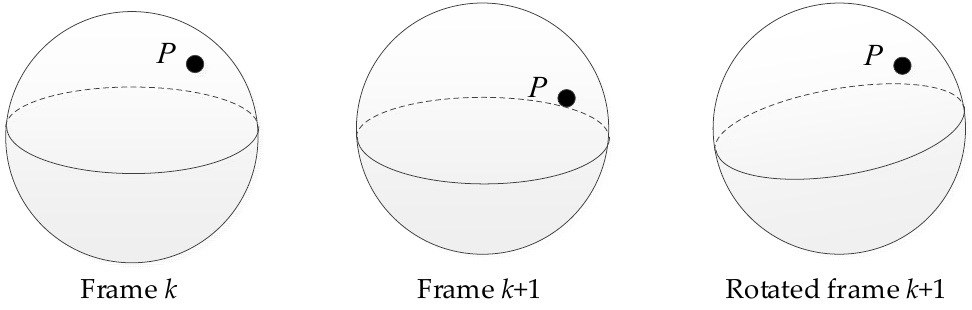
Figure 6. Spherical rotation compensation model.